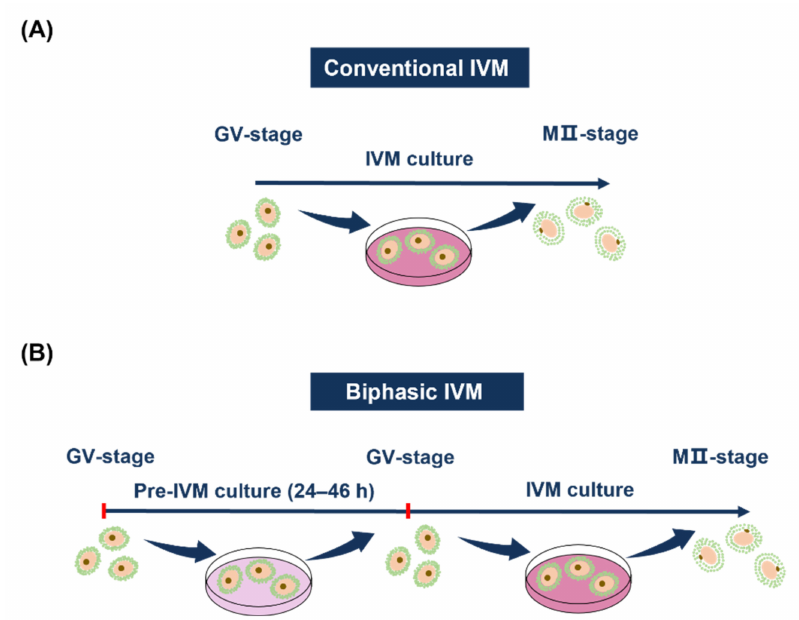
Figure 1. Conventional and biphasic IVM culture systems. ( A ) Conventional IVM system, only includes IVM culture phase. ( B ) Biphasic IVM system, includes a pre-IVM culture phase before IVM culture. The pre-IVM culture inhibits resumption of meiosis in immature oocytes and provides time for acquiring developmental potential. MII, metaphase